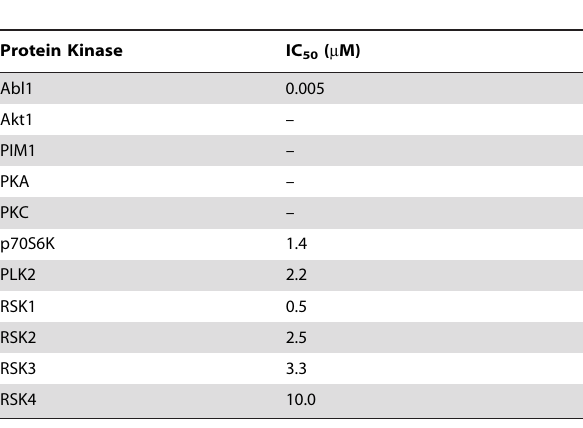
*SC-1 was evaluated for in vitro kinase inhibition utilizing a miniaturized 33 P- based screening assay [41]. The maximum concentration tested was 10 m M. IC 50 (inhibitory concentration of 50% of the control (DMSO) treatment) was calculated from a 3-fold serial dilution (n=2). Dashed lines indicate no effect at or below the maximum concentration tested.